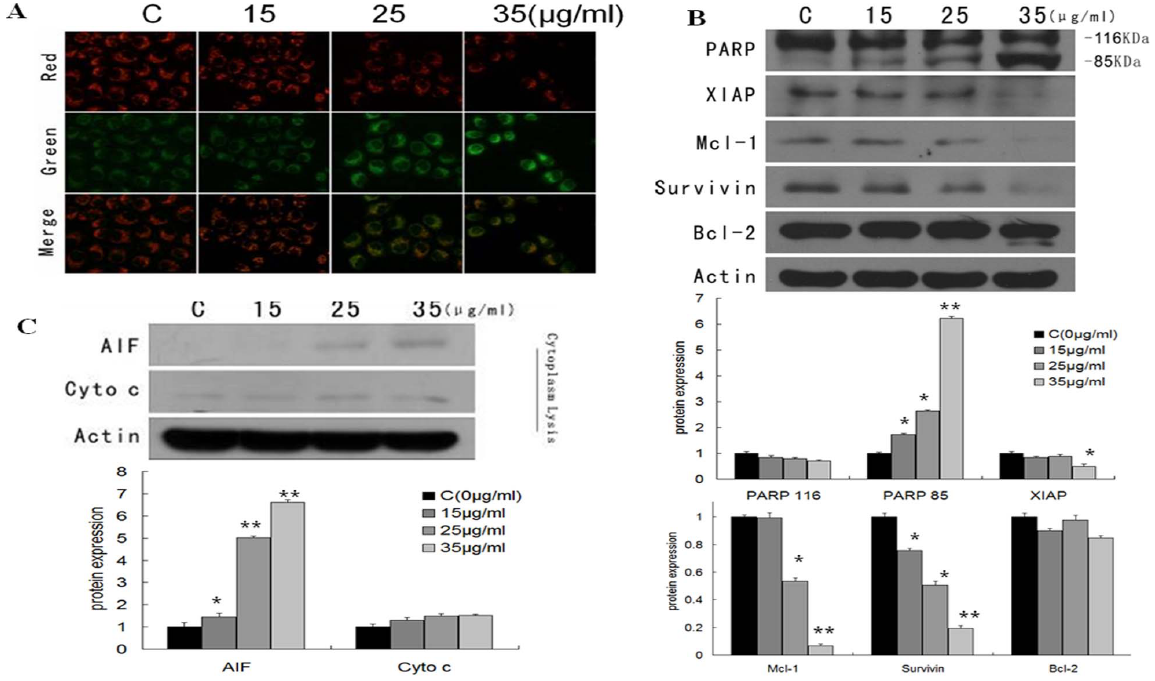
Figure 2. Effects of wogonin on mitochondrial membrane potential and apoptotic proteins in A549. (A) Analysis of the mitochondrial membrane potential ( DY m) using JC-1 staining after exposure to wogonin for 48 h. A fluorescence microscope was used to visualize the results. Mitochondrial depolarization was indicated by an increase in green fluorescence and a decrease in red fluorescence intensity. (B) Protein levels of Bcl- 2, Mcl-1, XIAP, survivin and PARP assayed by western blot. (C) Cytoplasmic proteins were extracted for western blot analysis of released Cytochrome c and AIF. In these experiments, cells were exposed to wogonin 0, 15, 25, 35 m g/mL for 48 h. * P , 0.05 vs control group, ** P , 0.01 vs control group.